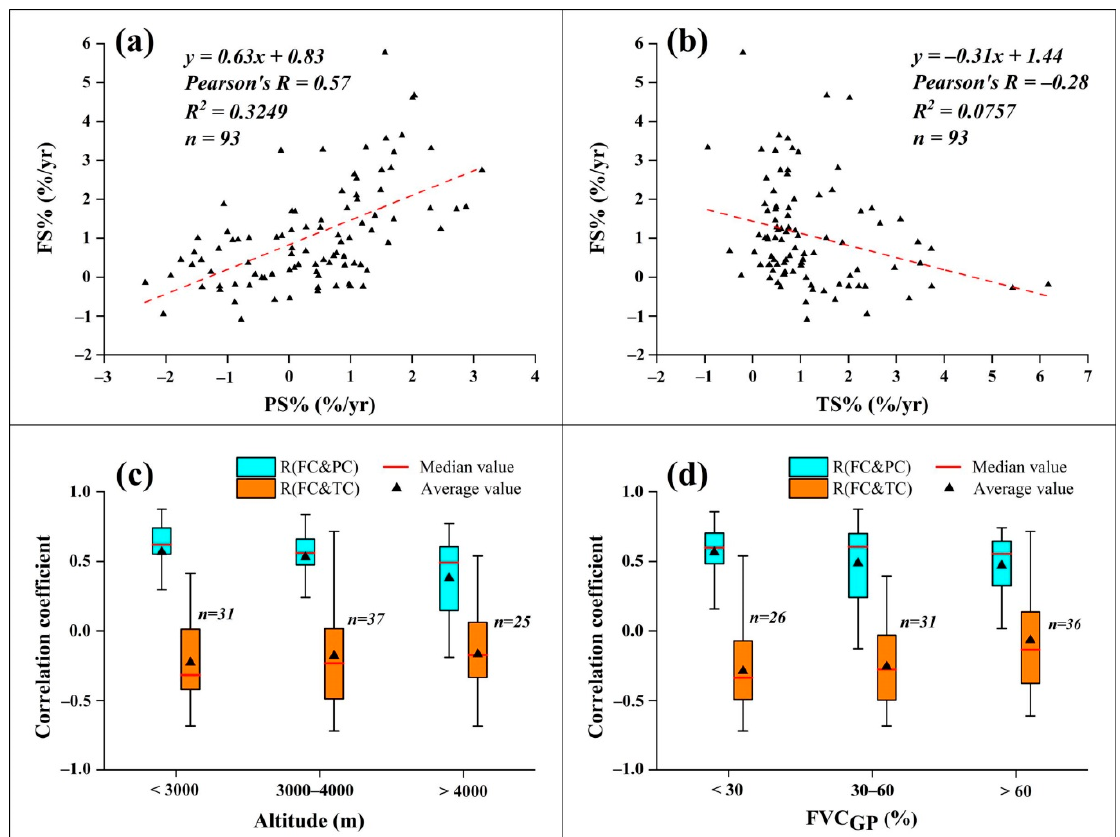
Figure 7. Correlation of grassland FVC GP change rates (FS%) related to ( a ) precipitation change rate (PS%) and ( b ) temperature change rate (TS%) in the TP, and variation of the correlation coefficient of FVC GP changes (FC) related to precipitation change (PC) and temperature change (TC), with ( c ) altitude and ( d ) FVC GP gradients.